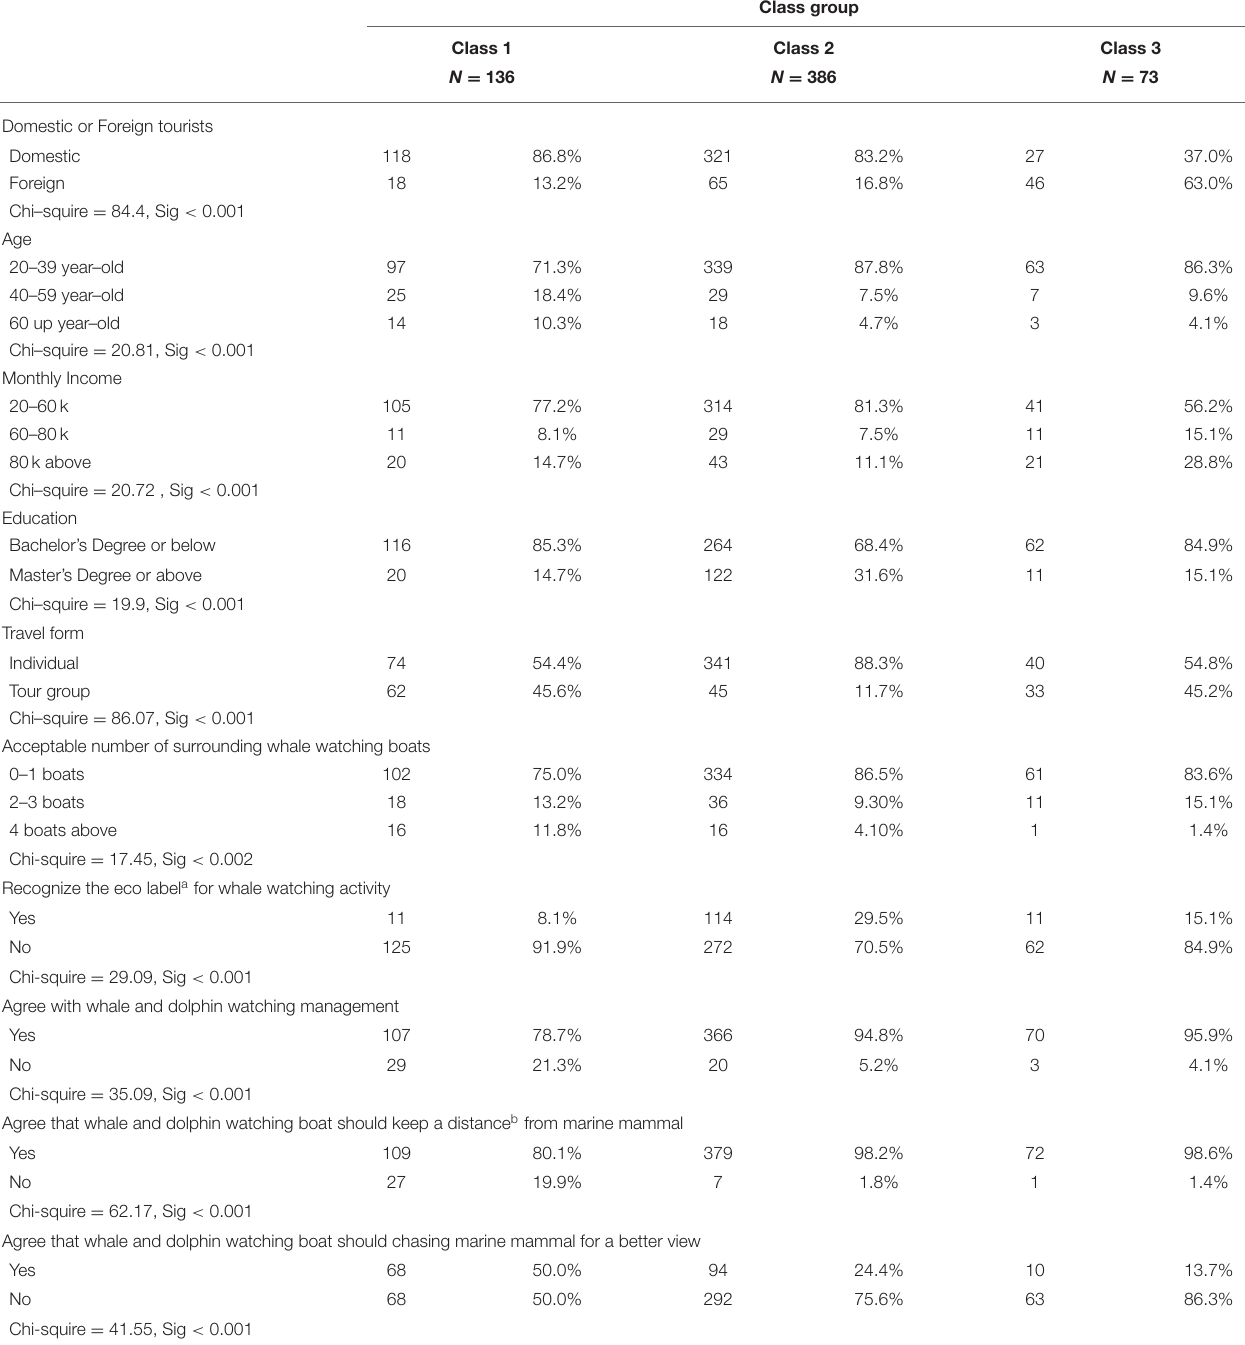
TABLE 6 | The class groups comparison among tourist’s demographics and the trip’s